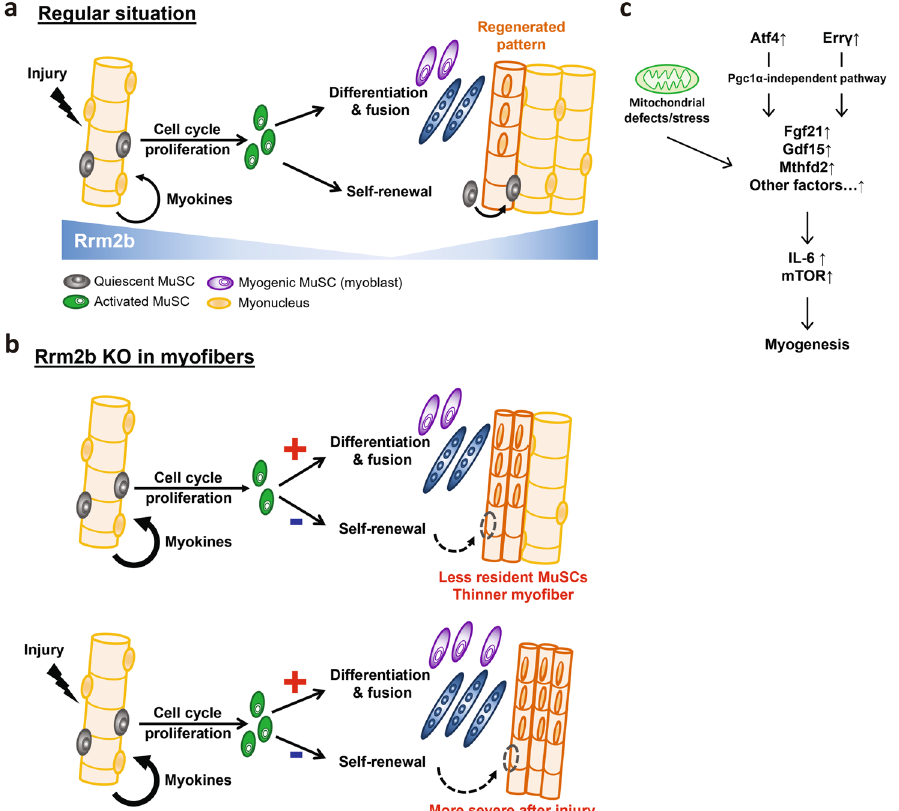
Fig. 8 Rrm2b deletion in the myo fi bers promotes differentiation and arrests quiescence of stem cells when skeletal muscle is injured. a Under muscle damage, quiescent MuSCs enter the cell cycle, proliferate, and are then activated. Activated MuSCs either differentiate to form new myo fi bers or self-renew to re-enter the quiescent stage. b In the Rrm2b knockout myo fi bers, increased myokines continuously drive spontaneous MuSC activation and differentiation but inhibit self-renewal, resulting in a low number of MuSCs and myo fi ber weakness. c Our working hypothesis revealed that Atf4 and Err γ through PGC1 α -independent signaling pathways and mitochondrial defects, upregulated expressions of Fgf21, Gdf15, Mthfd2 and other factors, which associated myogenesis in the Rrm2b-deleted myo fi